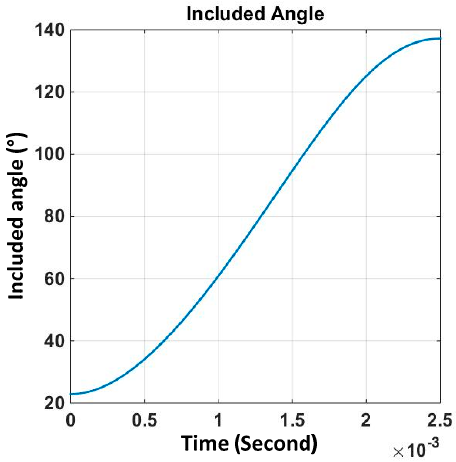
Figure 4. Angular velocity of the two rotors.